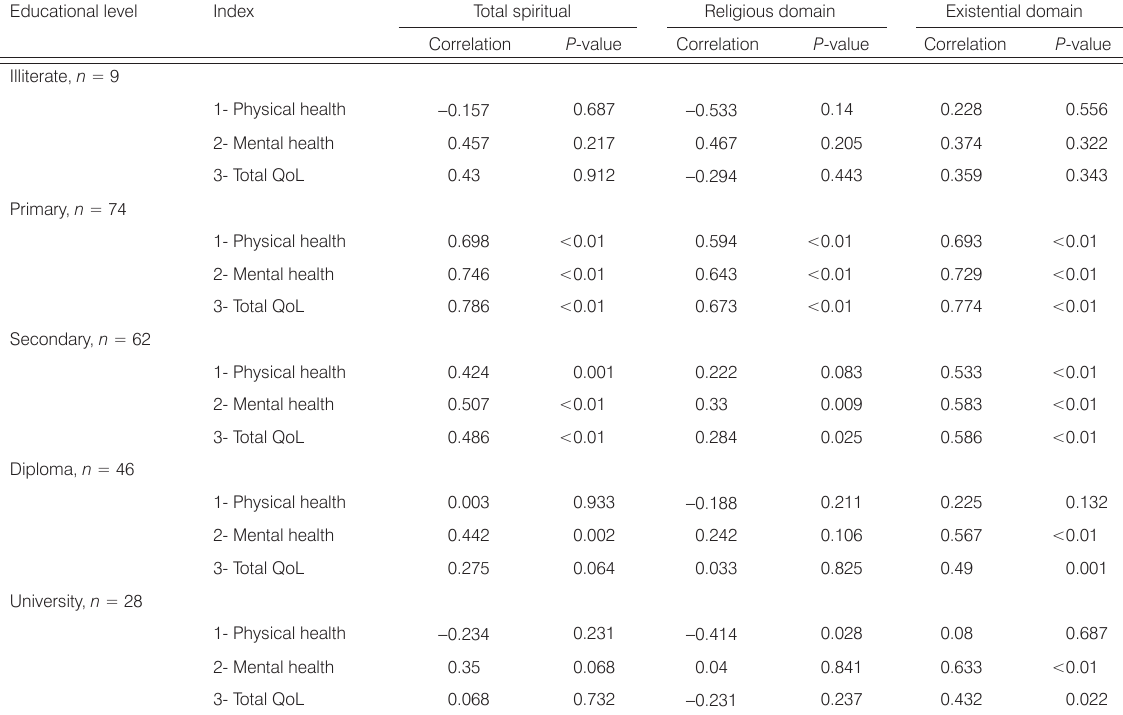
Table 4. The relationship between spiritual well-being and QoL dimension according to education